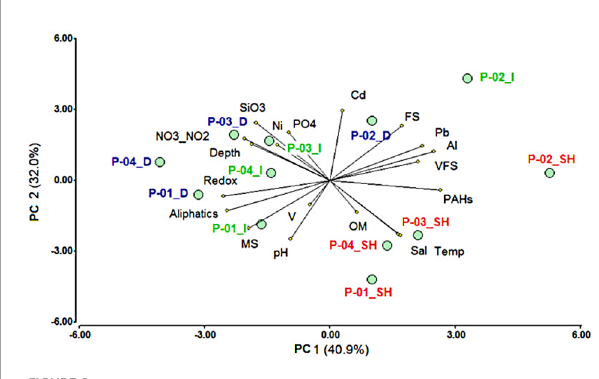
FIGURE 2 Principal component analysis of environmental variables through campaigns and sampling zones. Labels P-01, P-02, P-03, and P-04 indicate the campaign, followed by the sampling zone: shallow (SH) in red, intermediate (I) in green, and deep (D) in blue. Sampling zone categories were de fi ned according to the total water depth of each sampling site. SH sites: ≤ 200 m, I sites: 201-1200 m, and D sites: 1201-3573